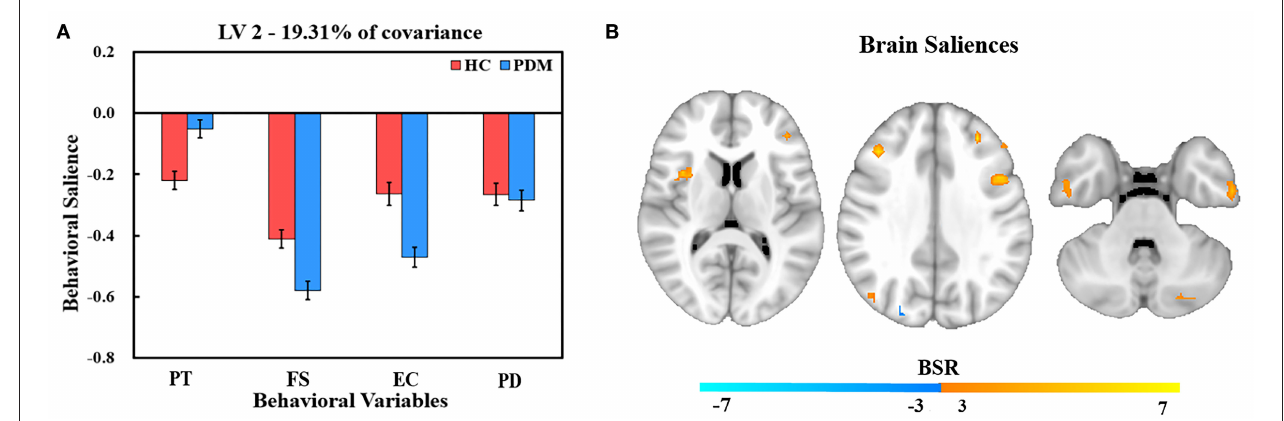
FIGURE 3 | PLS correlation analysis results of LV 2. (A) Bar graph of behavioral salience with stability estimated based on the use of bootstraps in the two groups. (B) Resting brain activity showing brain regions in which variations were associated with trait empathy. The map is the threshold at the equivalent value of p = 0.01 (BSR = ± 3). Owing to the negative salience in both groups, warm regions indicated a negative correlation between resting brain activity and empathy, while cool regions showed a positive correlation between resting brain activity and